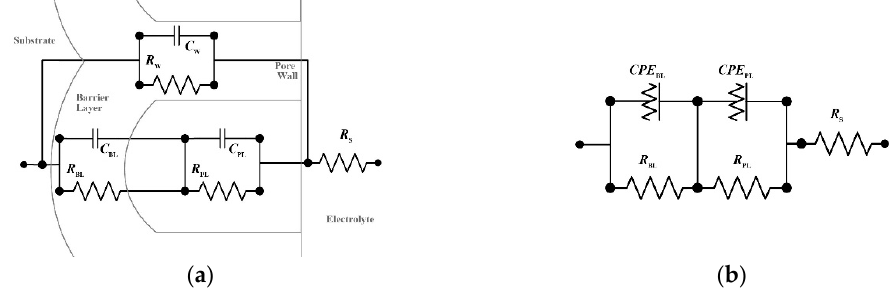
Figure 6. ( a ) General EEC configuration for AAO; and ( b ) the simplified circuit used to model the sealed anodized samples.